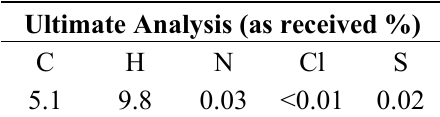
Table 2. Analysis of the aqueous fraction of condensate produced from MGW pyrolysis.